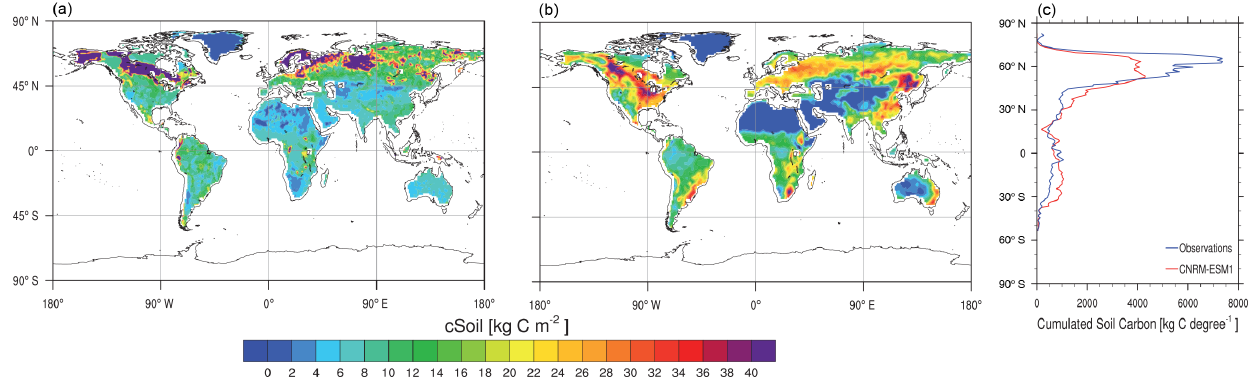
Figure 13. Stocks of modern soil organic carbon (cSoil) as estimated from the FAO/IIASA/ISRIC/ISSCAS/JRC (2012) Harmonized World Soil Database (a) and as simulated by CNRM-ESM1 (b) averaged over 1986–2005. Panel (c) represents the zonally cumulated soil organic stock in function of latitude for both observation-based estimates (in blue) and CNRM-ESM1 (in red). Tracers: